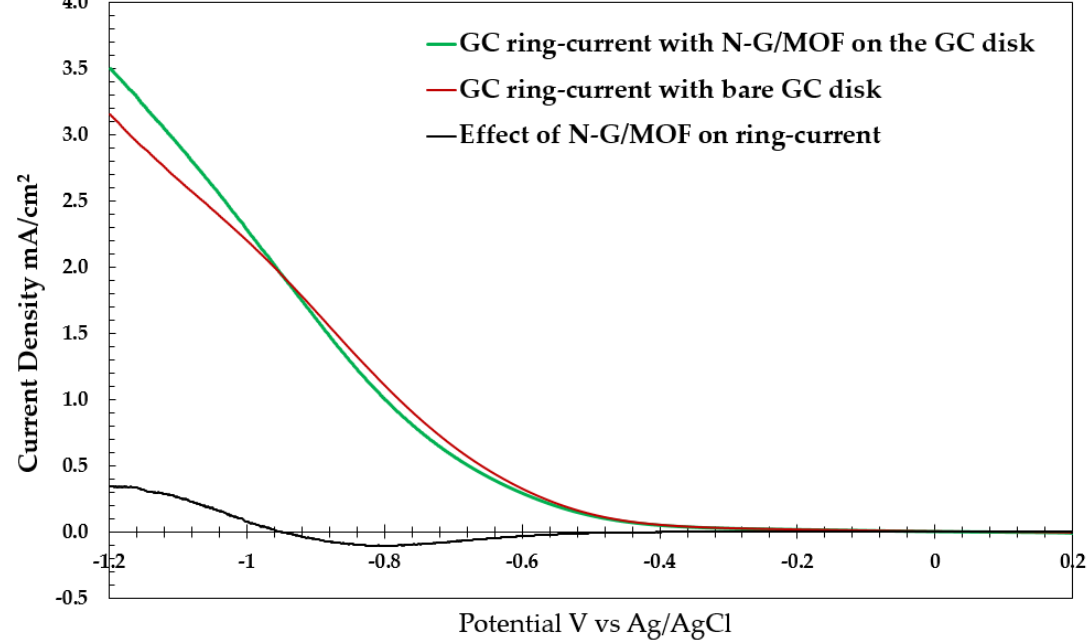
Figure 4. LSV curves for ring-currents from the RRDE experiments with two conditions of disk sur- face (green and red lines) and the effect of N-G/MOF on ring-current (black line). surface (green and red lines) and the effect of N-G/MOF on ring-current (black